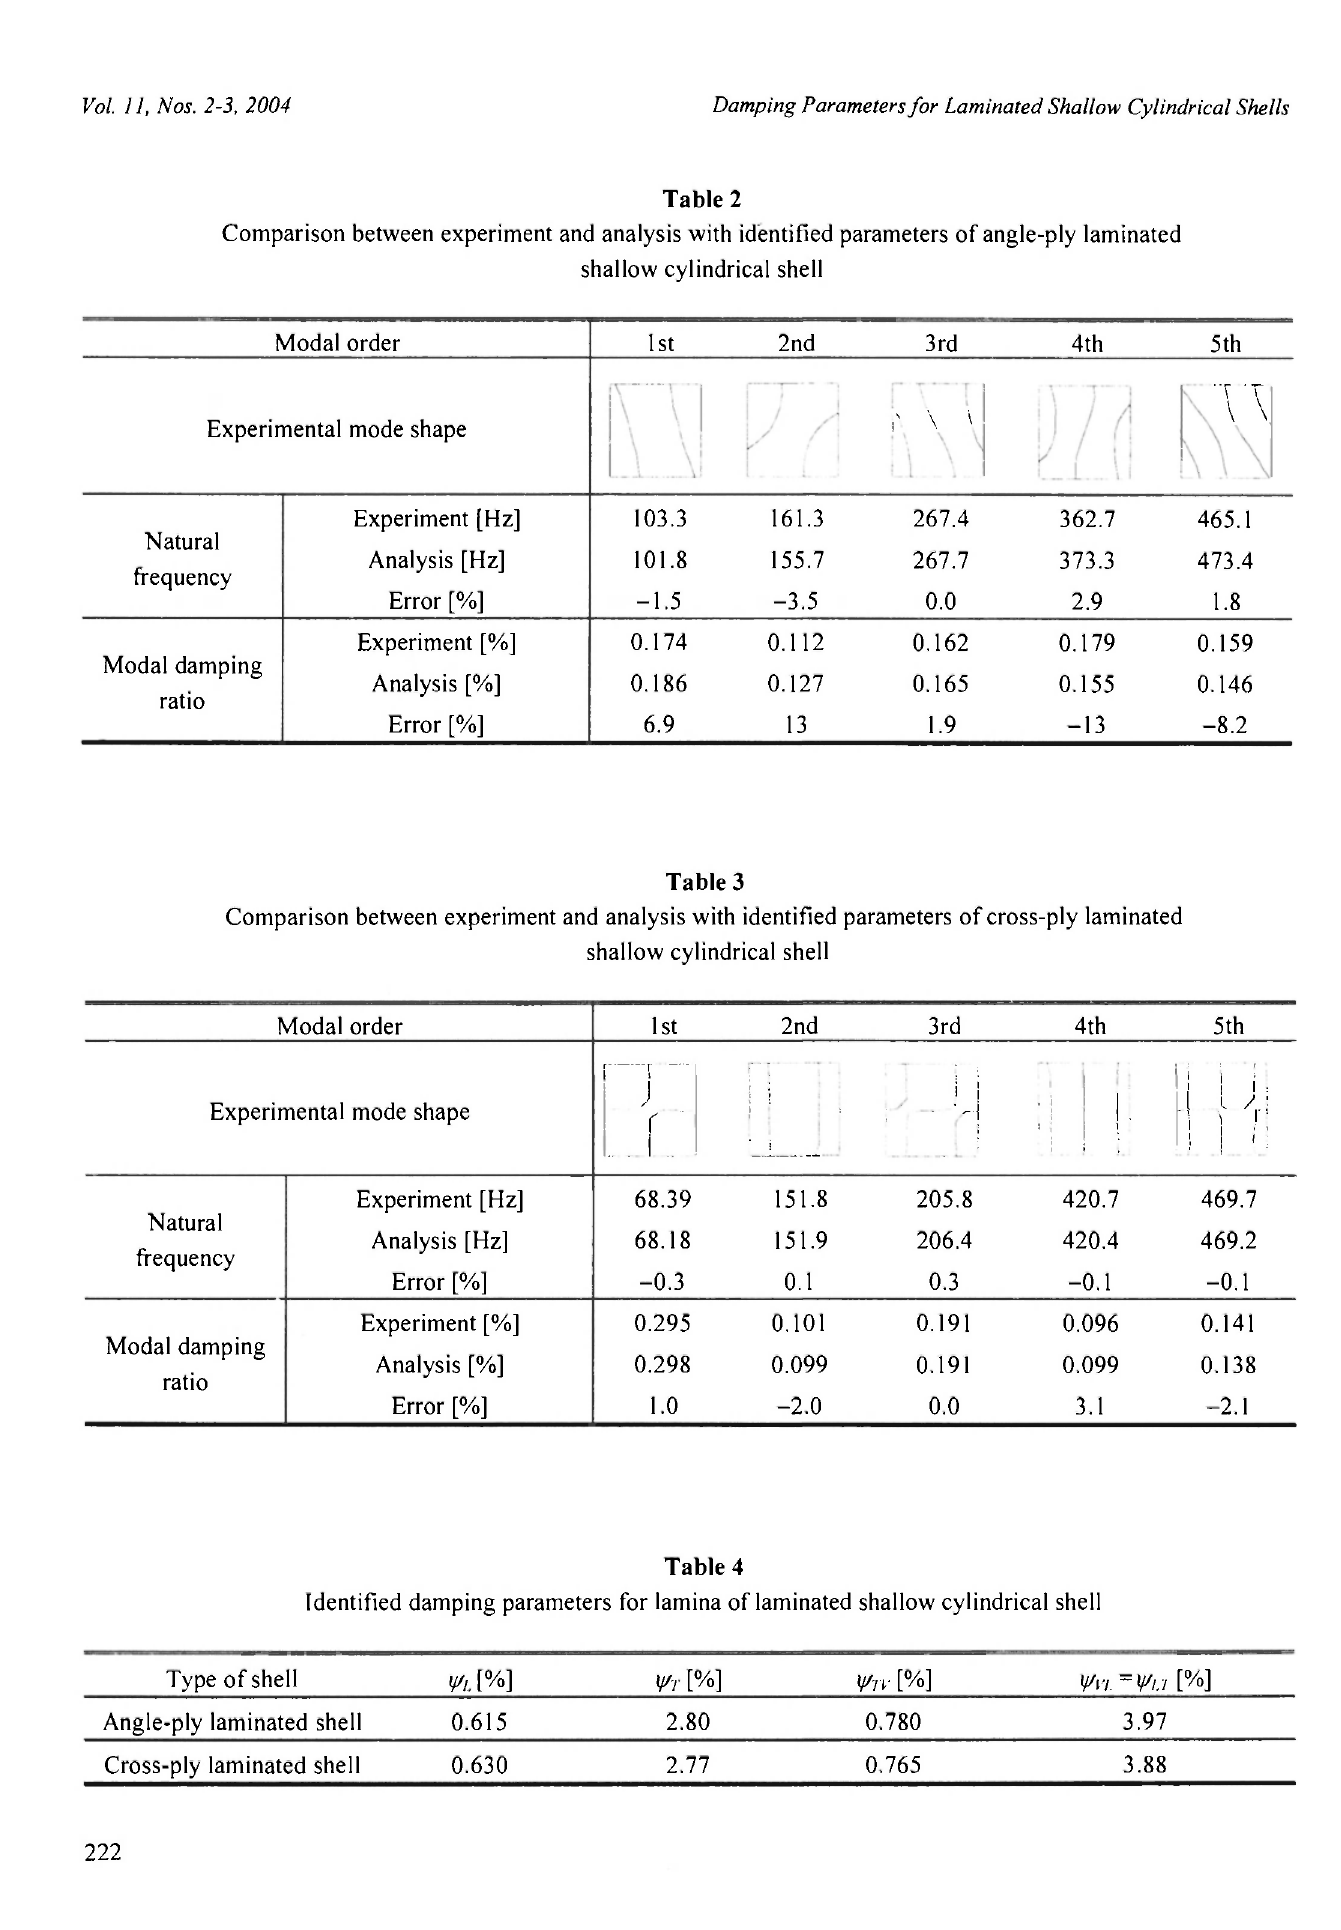
Comparison between experiment and analysis with identified parameters of cross-ply